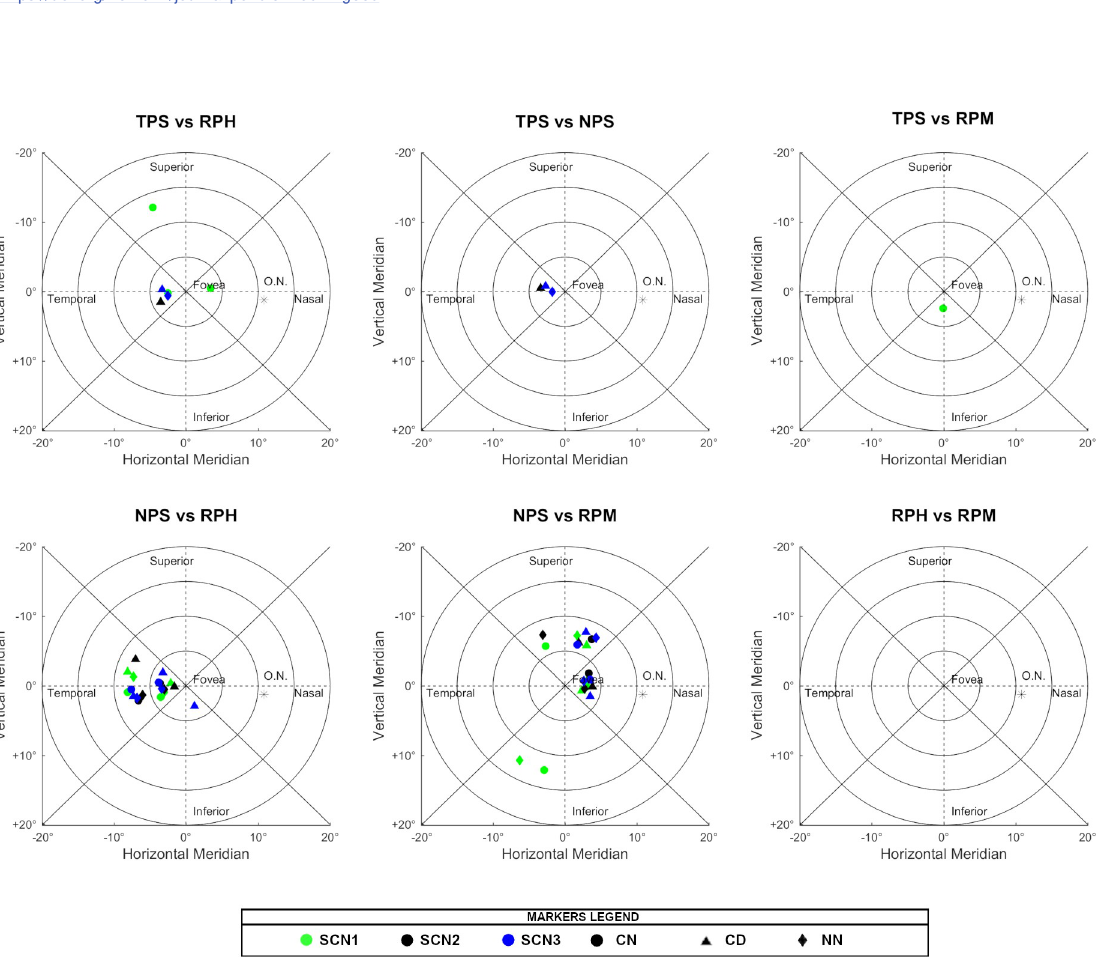
Fig 6. Non-significant differences in the post-hoc analysis when comparing the different types of peripheral refraction. The absence of markers indicates that those regions were significantly different under all conditions tested.